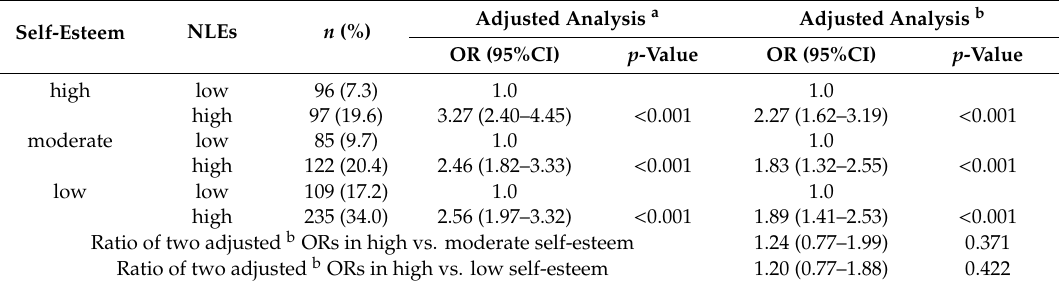
Table 5. Number, %, and OR of SI in relation to NLEs by level of self-esteem in males: 15-school study,